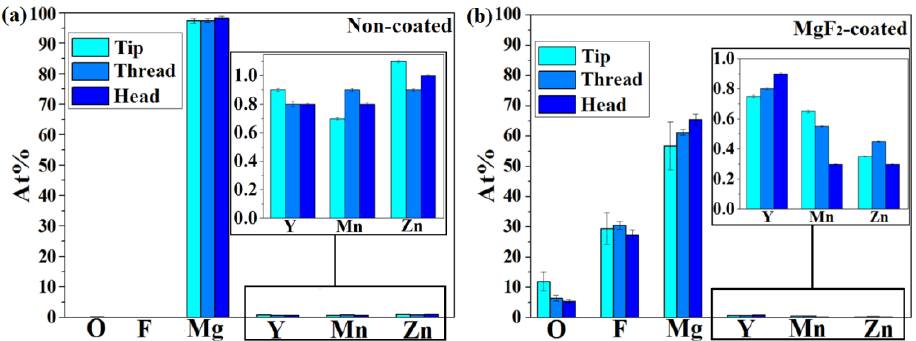
Figure 4. EDS analyses of areas in Figure 2 for non-coated ( a ) and MgF 2 -coated samples ( b ).